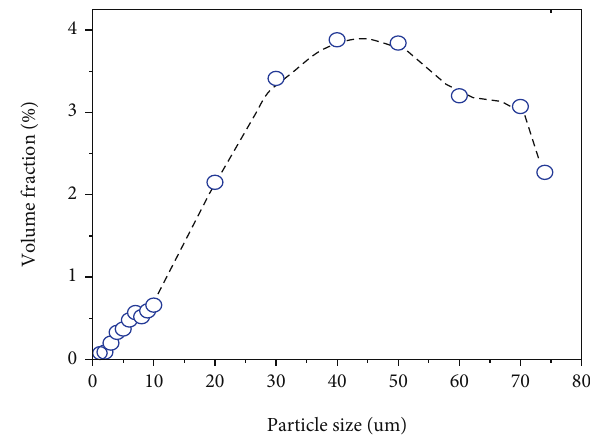
Figure 16: Volume fraction of tailing sand particle residue in geotextile compared with the measurement results of the third time.